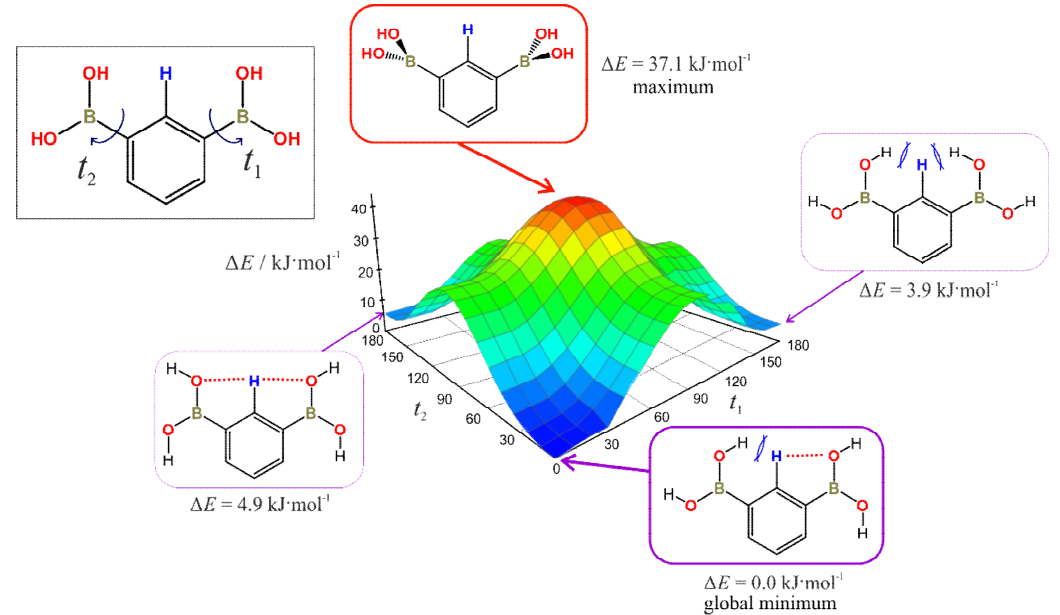
Figure 11. The energy profile for rotation of two boronic groups in respect to the phenylene ring fragment.